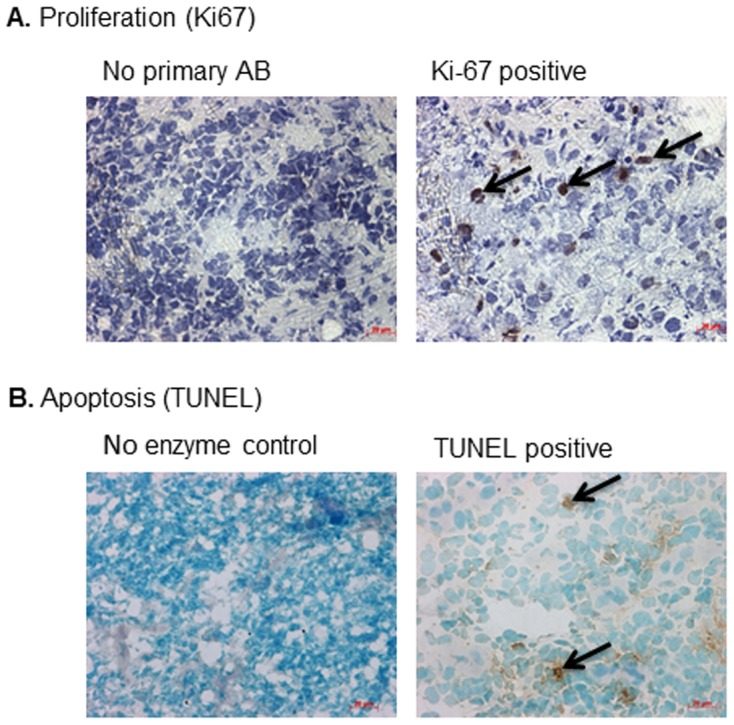
A. Immunohistochemistry for Ki-67 performed on primary ESFT (5 µm).Ki-67 protein was visualised with the DAB substrate, proliferating cells are identified by Ki-67 positive nuclei (see arrows). Immunohistochemistry performed in the absence of primary antibody was included to control for non-specific binding of the secondary antibody (No primary AB). Magnification ×400. B. TUNEL on primary ESFT (5 µm). Apoptotic cells were identified by TUNEL positive nuclei (see arrows). The TUNEL assay was performed in the absence TdT enzyme to control for non-specific staining (No enzyme). Magnification ×400.